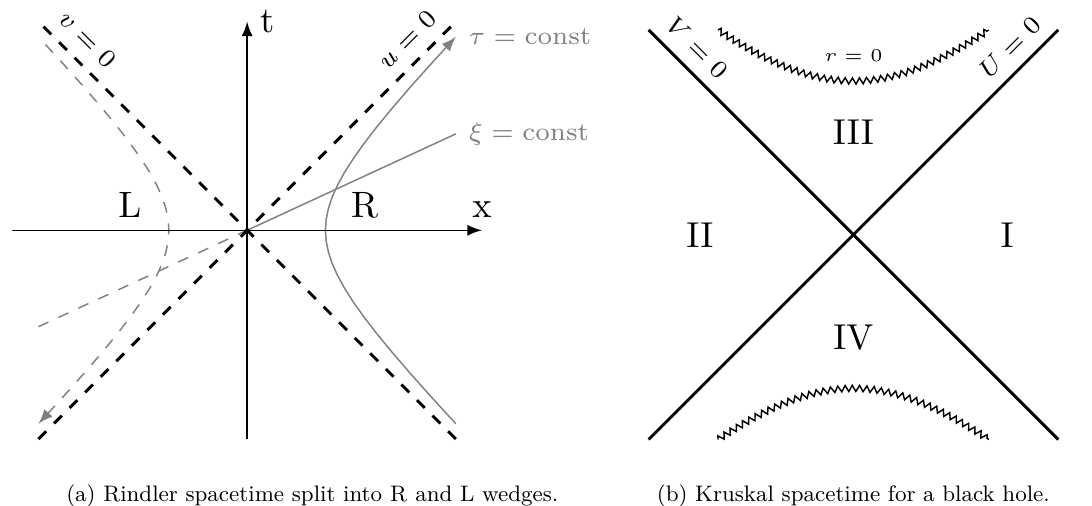
Figure 5. Spacetime diagrams for Rindler and Kruskal